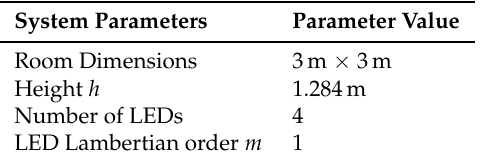
Table 1. The system parameters of the experimental set-up .